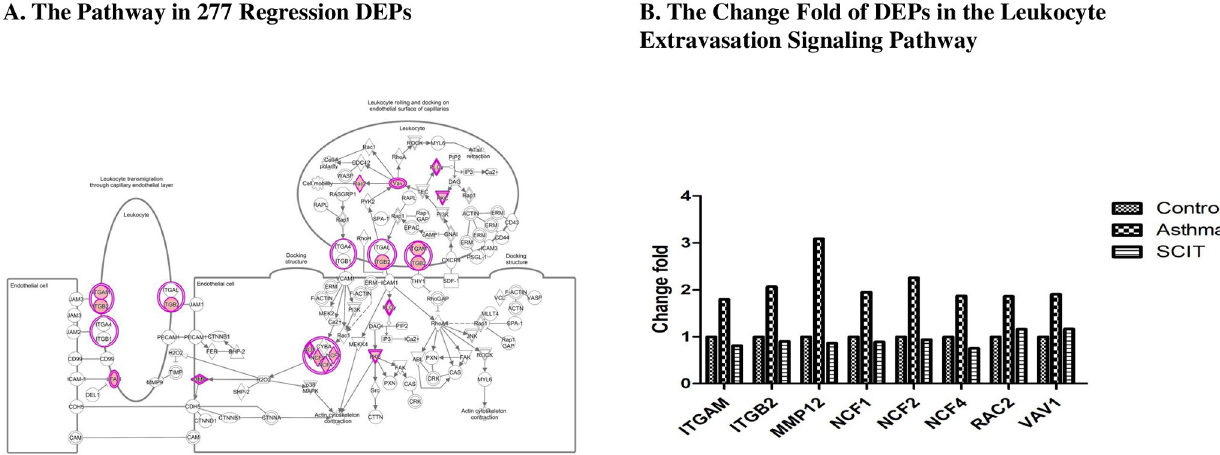
Fig 6. The leukocyte extravasation signaling assigned by the IPA software map. Each line suggested protein-protein interaction. Solid line indicated direct interaction while dashed line means indirect interaction. Red colors pointed to the up-regulation of the expression of DEPs in asthma condition. A. The leukocyte extravasation signaling pathway of 277 regression DEPs. B. The change fold of DEPs in the leukocyte extravasation signaling pathway based on the protein’s abundances.